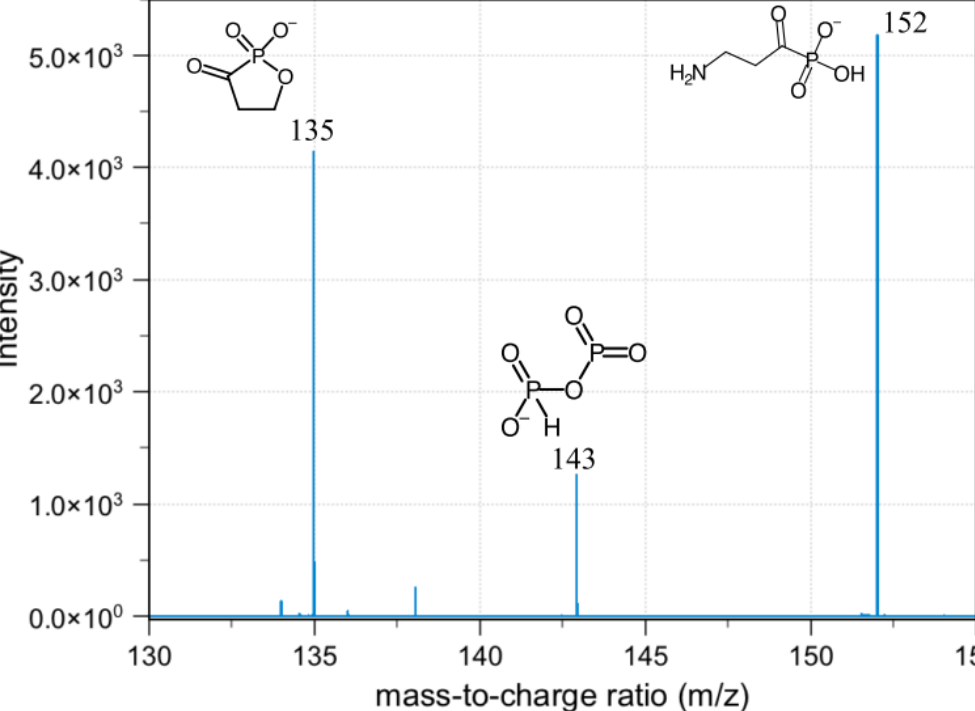
Figure 11. Diagnostic ion for bisphosphonates observed at m / z 143.